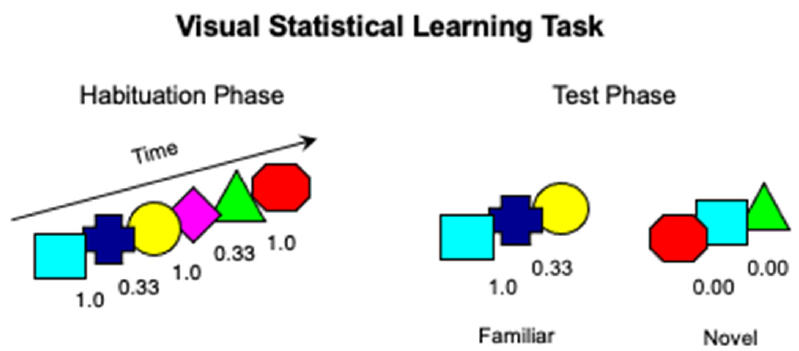
Figure 1. Schematic representation of the stimuli and procedure used in the visual Statistical Learning (SL) task (Study 1).